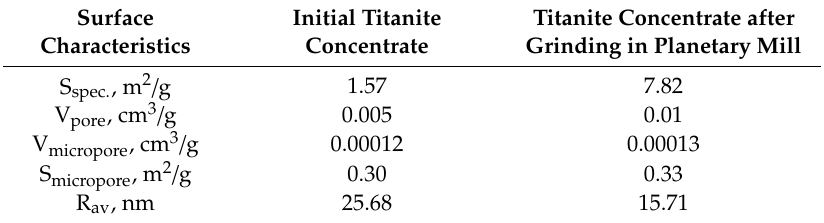
Table 3. Surface properties of original and ultra-ground